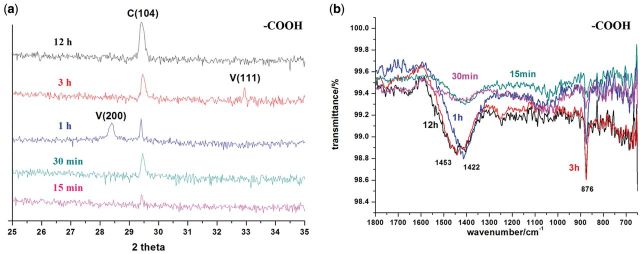
XRD patterns (a) and FTIR-ATR spectra (b) of CaCO3 formed on −COOH surface at 15, 30 min, 1, 3 and 12 h. C, calcite; V, vaterite.